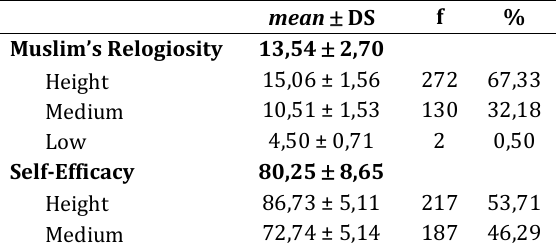
Table 2. The Mean of Muslim Religiosity Score and Self-Efficacy in Prevention of HIV-Risk Behaviour (n = 404)